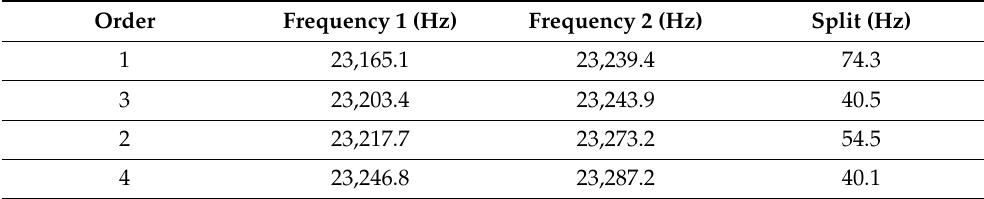
Table 3. Record of the frequency split for continuous punching holes at 45 ◦